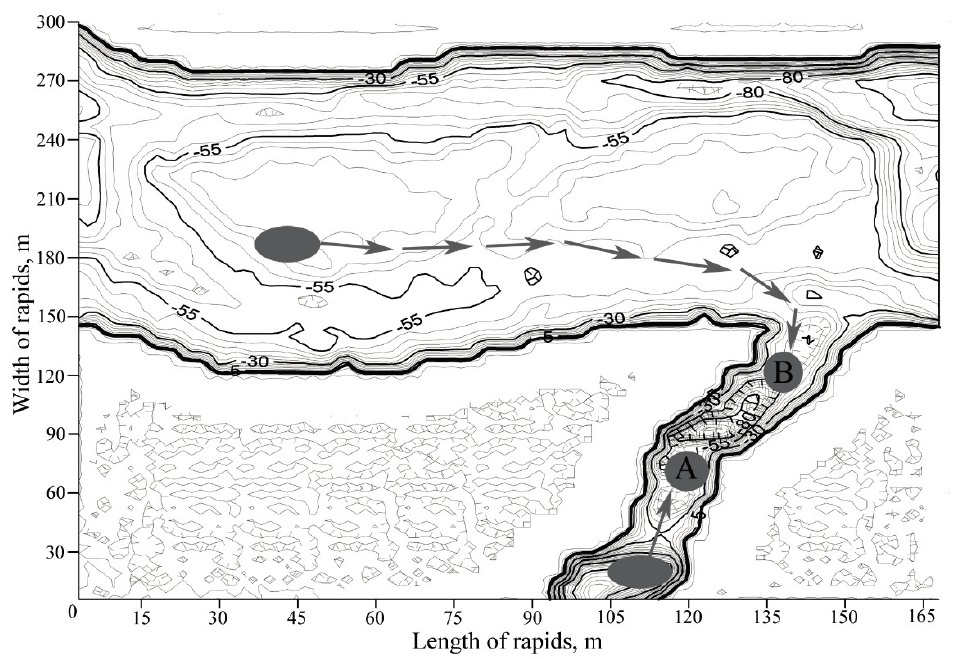
Figure 1. Hatching locations of the juvenile salmon in the Arenga tributary (marked as an oval from which the generation A formed) and mainstream of the Varzuga River (marked as an oval from which the generation B formed). Arrows show the migration of fingerlings and origins of the two generations.